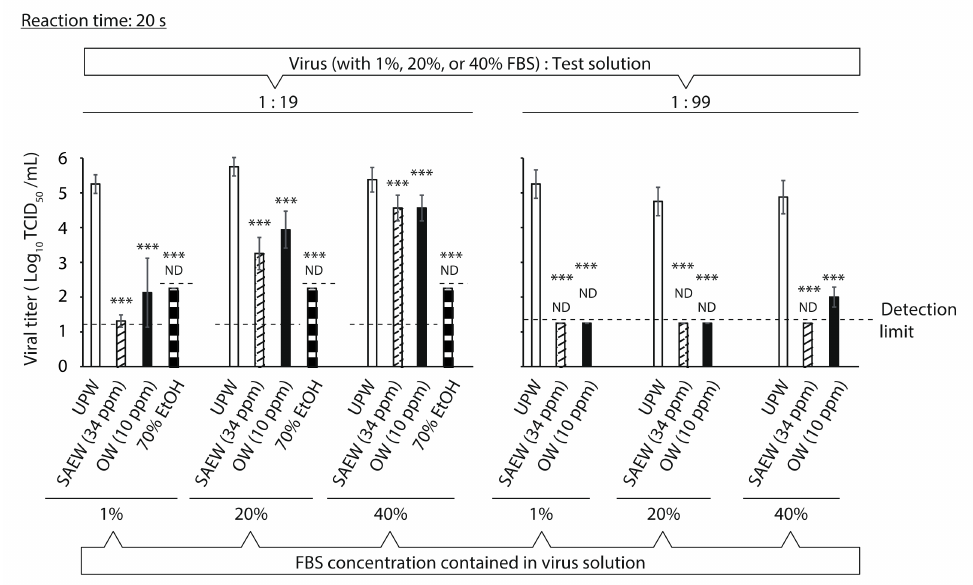
Figure 2. Evaluation of the impact of fetal bovine serum (FBS) concentration in the virus solution on the virucidal activities of test solutions. The viral titer of each reaction mixture was measured. Results are indicated as mean ± standard deviation ( n = 4–8 per group). The detection limits of the viral titer are 1.25 log 10 50% tissue culture infective dose (TCID 50 )/mL in the ultra-pure water (UPW), slightly acidic electrolyzed water (SAEW) and ozonated water (OW) groups, and 2.25 log 10 TCID 50 /mL in the 70% ethanol (EtOH) group. ND is the abbreviation for not detected, which means that the viral titer was below the detection limit. Student’s t -test was performed to analyze the statistical significance between the UPW (control) group and each test solution group; *** p < 0.001.